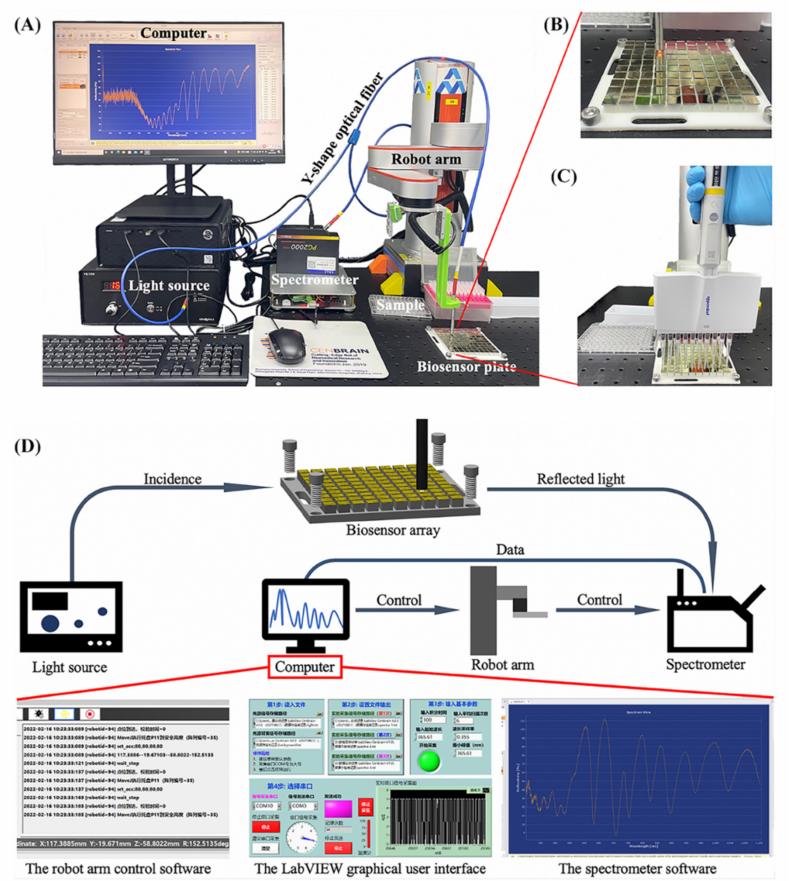
Figure 2. The automatic detection system used in this study. ( A ) The robot arm system for automatic detection including the computer, the light source, the spectrometer, the Y-shaped optical fiber, the sample, and the biosensor detection array; ( B ) zoom in of the automatic measurement of the reflectance spectrum; ( C ) the automated sampling process empowered by multi-channels; ( D ) the working principle of the automatic detection